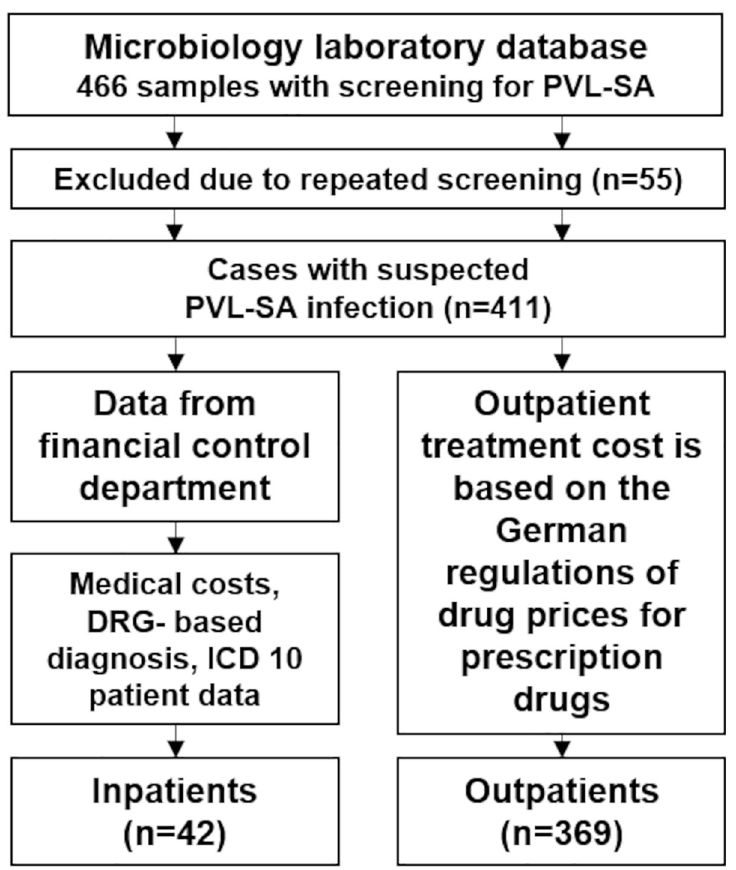
Fig 1. Overview data. PVL, Panton-Valentine leukocidin. SA, Staphylococcus aureus . DRG, Diagnosis Related Groups. ICD, International Classification of Diseases (Medical classification code for systematizing